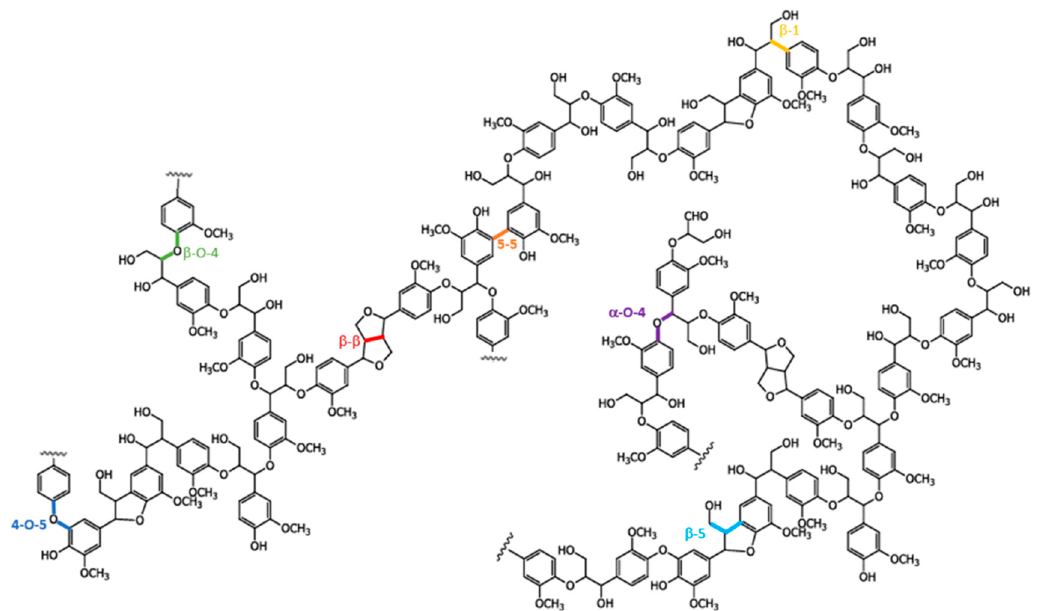
Figure 1. Example of lignin structure. Reproduced with permission from Chávez-Sifontes, Lignina, estructura y aplicaciones: métodos de despolimerización para la obtención de derivados aromáticos de interés industrial; published by Avances en Ciencias e Ingeniería, 2013.